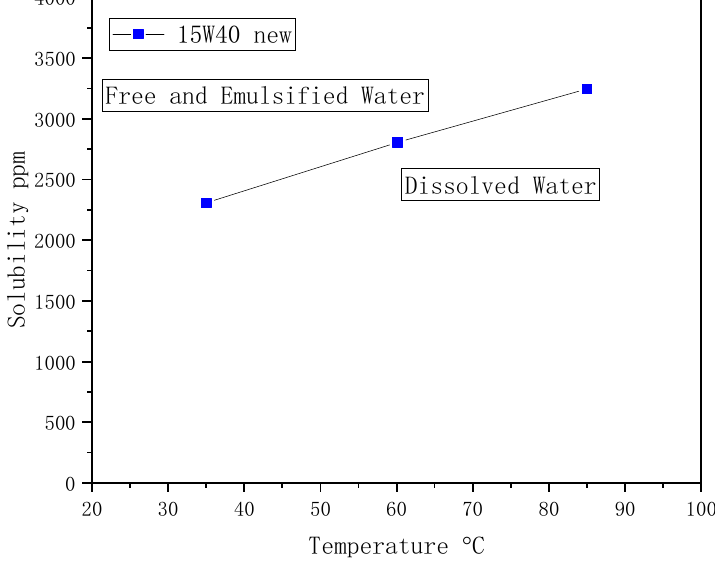
Figure 10. Typical water solubility in engine oil and associated water states. Solubility depends on temperature, oil additives, contamination, and oxidation [9]. Water has low solubility in pure oils and hydraulic oils. Typical solubility in engine oil is approximately 2000 ppm at 50 ◦ C. The solubilities of water in hydraulic oil and fresh and aged 15W40 engine oils, as measured by a water content sensor, are presented in Figure 11.